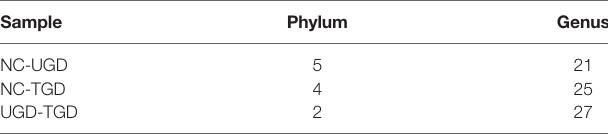
The fi rst column in the table shows the pairwise comparison groups. “ Phylum ” and “ Genus ” correspond to the number of taxa with signi fi cant differences at the phylum and genus levels in each